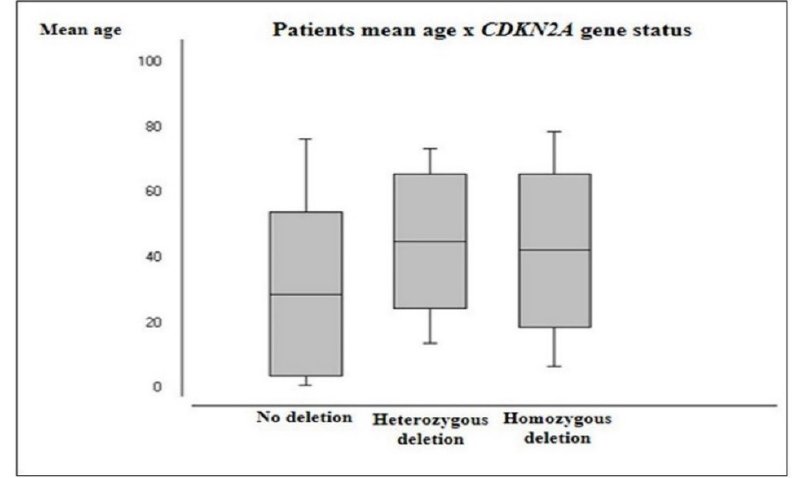
Figure 7. Patients’ mean age according to CDKN2A gene status. Table 5. Frequency of CDKN2A deletion in each histologic and WHO grading group.